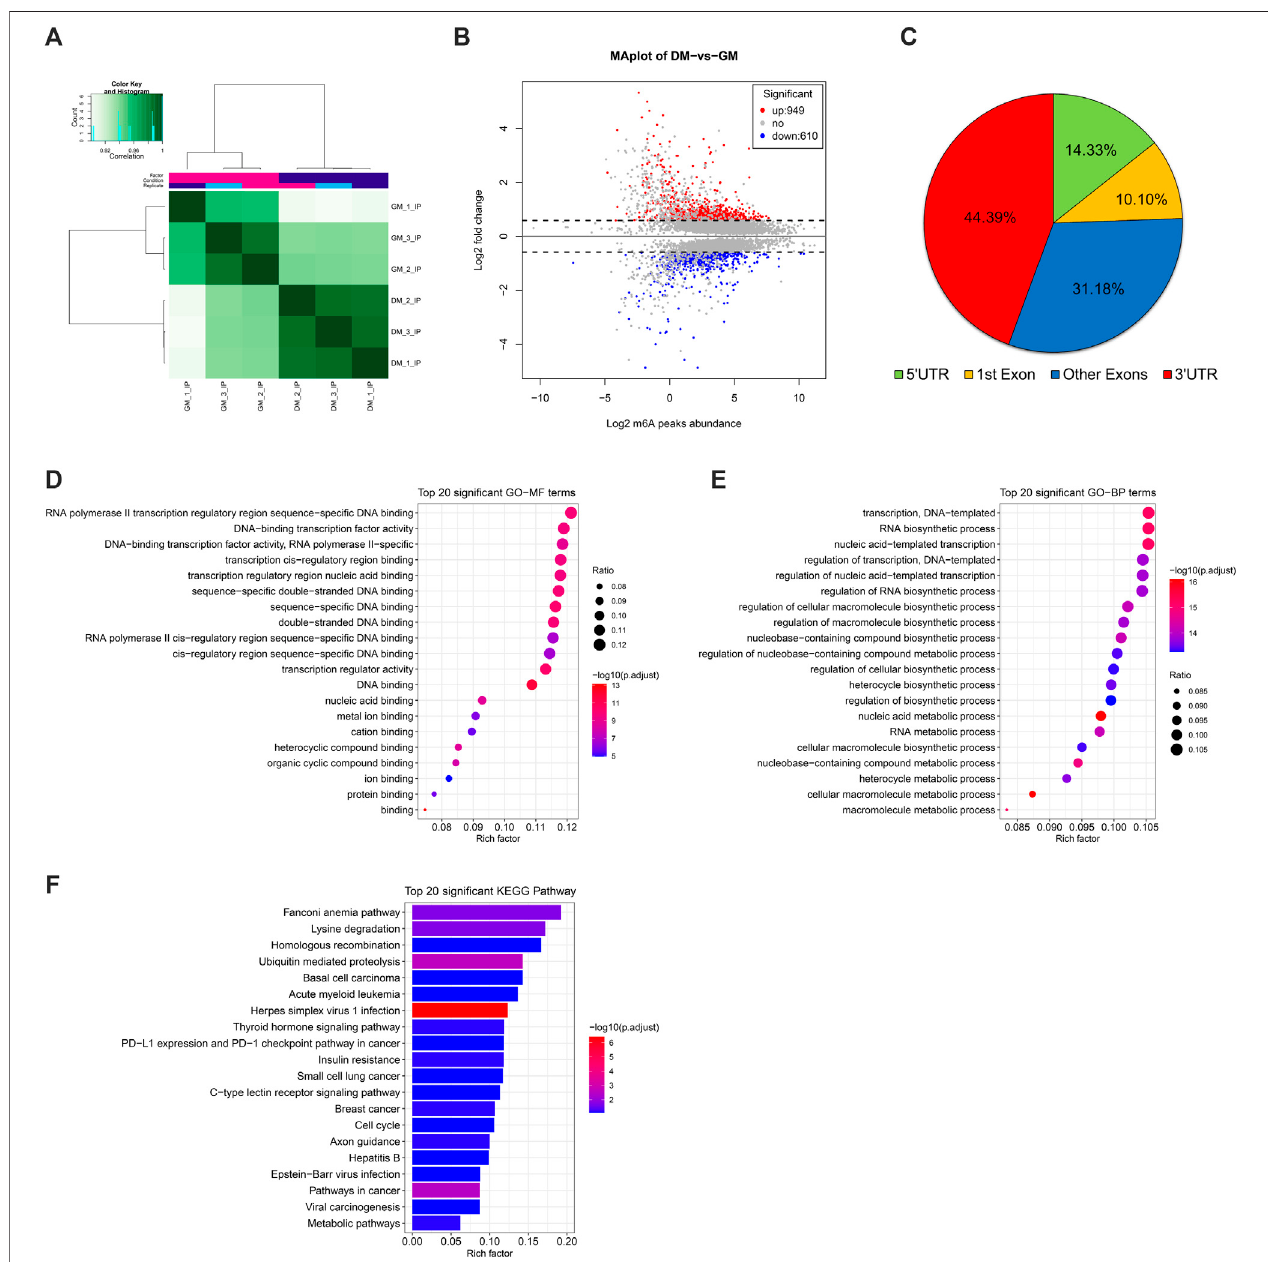
FIGURE 3 | Analysis of differentially methylated peaks (DMPs) between bovine skeletal myoblasts and myotubes. (A) Correlation heatmap showing the correlation between GM_IP and DM_IP. (B) MA plot showing DMPs between DM_IP and GM_IP. (C) Pie chart showing the fraction of m 6 A peaks in 4 non-overlapping transcript segments (5 ′ UTRs, 1st exon, other exons, and 3 ′ UTRs). (D) Gene ontology (GO) enrichment analysis of molecular function for differentially methylated genes (DMGs). (E) GO analysis of biological process for DMGs. (F) KEGG analysis of DMGs.